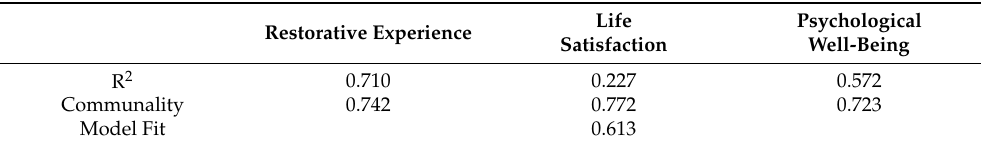
Table 5. Overall model